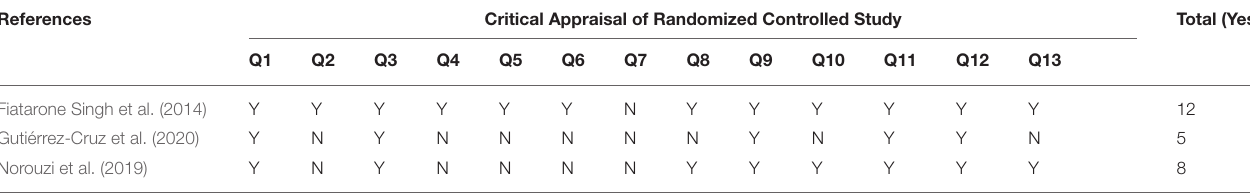
TABLE 2 | Assessment of methodological quality of the included studies using the JBI critical appraisal checklist for